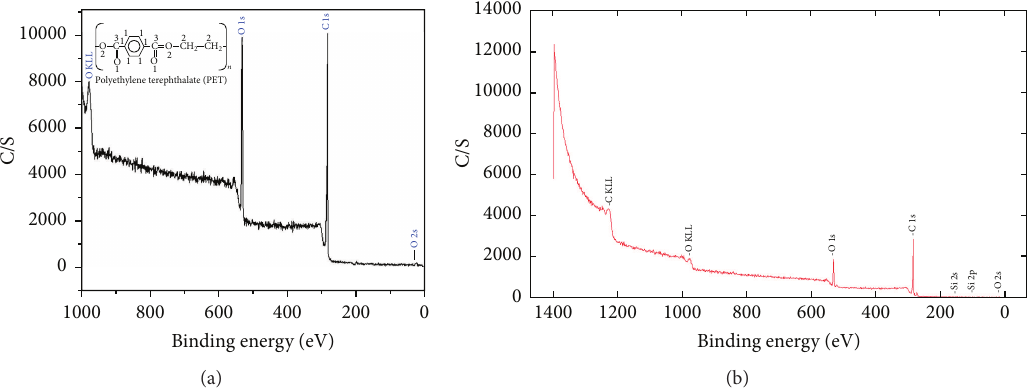
Figure 4: (a) XPS spectral analysis of PET surface from control samples before storage; (b) XPS spectral analysis of PET surface in microzones of salmon adhesion and